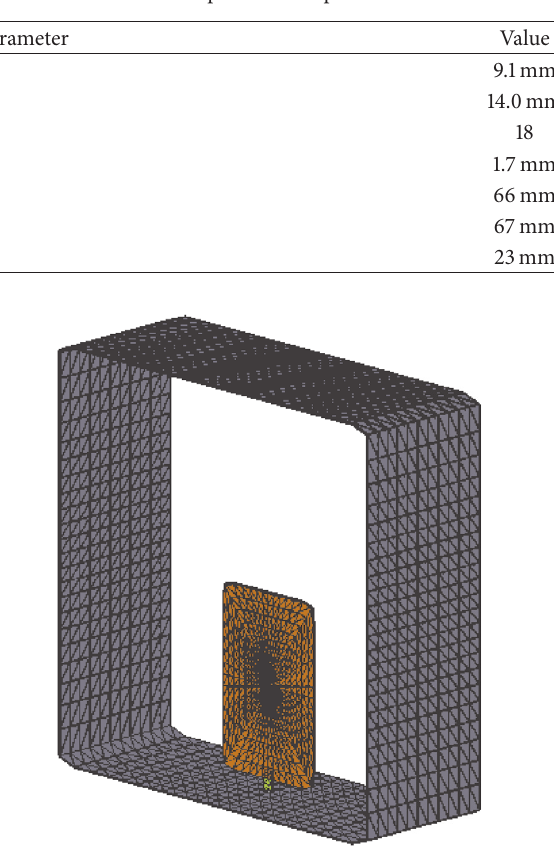
Figure 9: The final triangulated antenna structure.